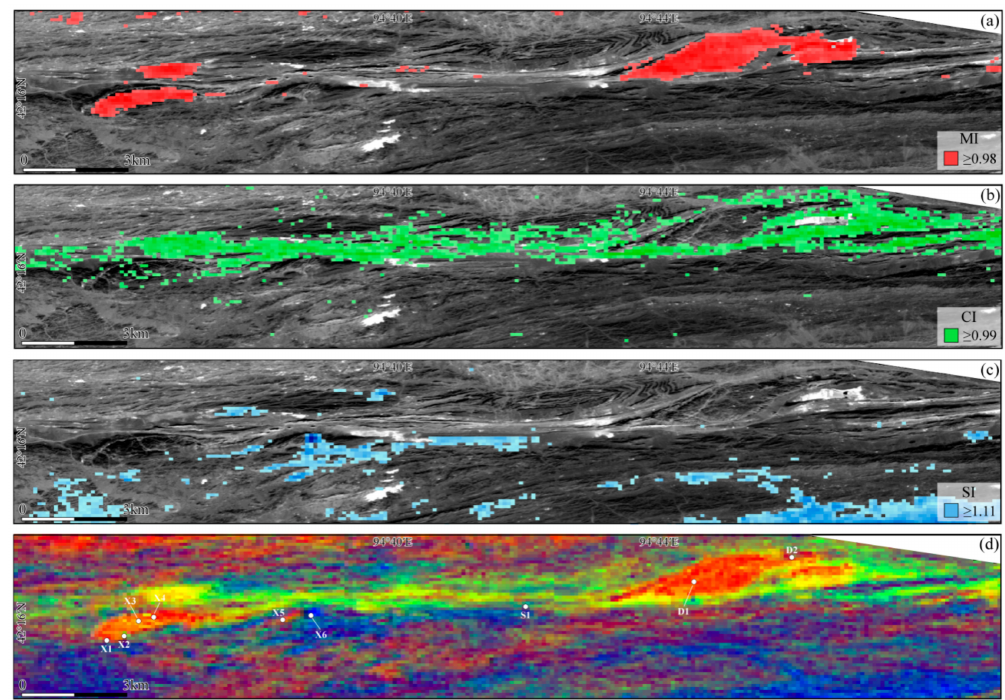
Figure 6. The lithological information extracted from the ASTER MI ( a ), CI ( b ), SI ( c ) superimposed on ASTER band 1 image and the false-color composite image of MI (R), CI (G), and SI (B) ( d ) in the study area. White circles represent the location of the samples.